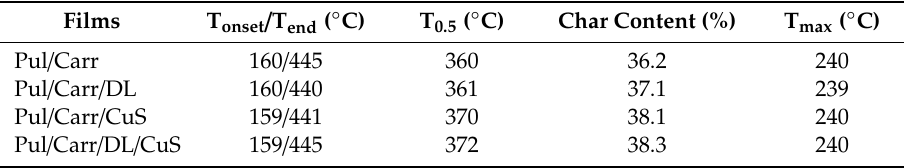
Table 3. Thermogravimetric data of pullulan / carrageenan-based